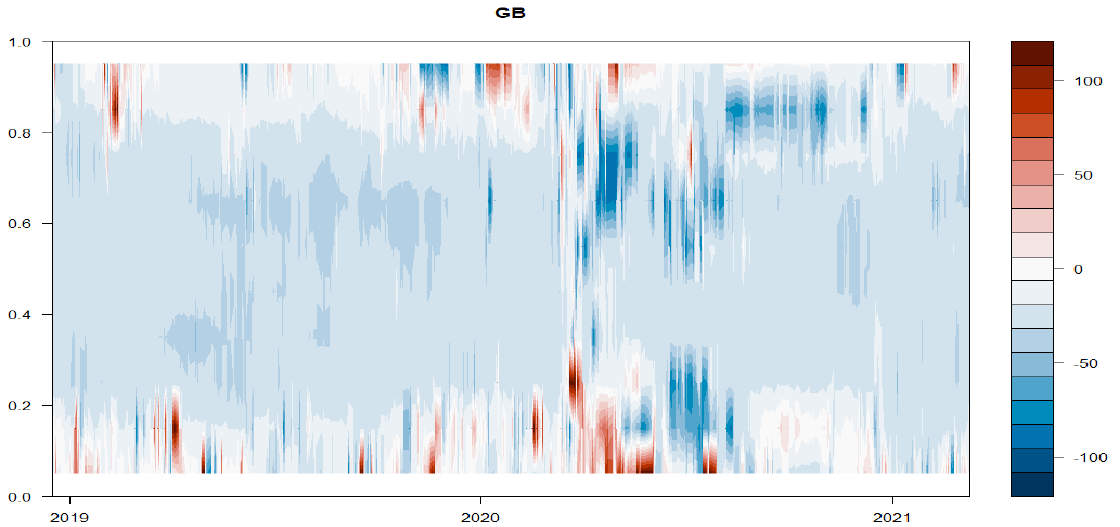
Figure 3. Results for dynamic total connectedness based on a 200-day rolling-window QVAR(1) model and a 20-step-ahead forecast.